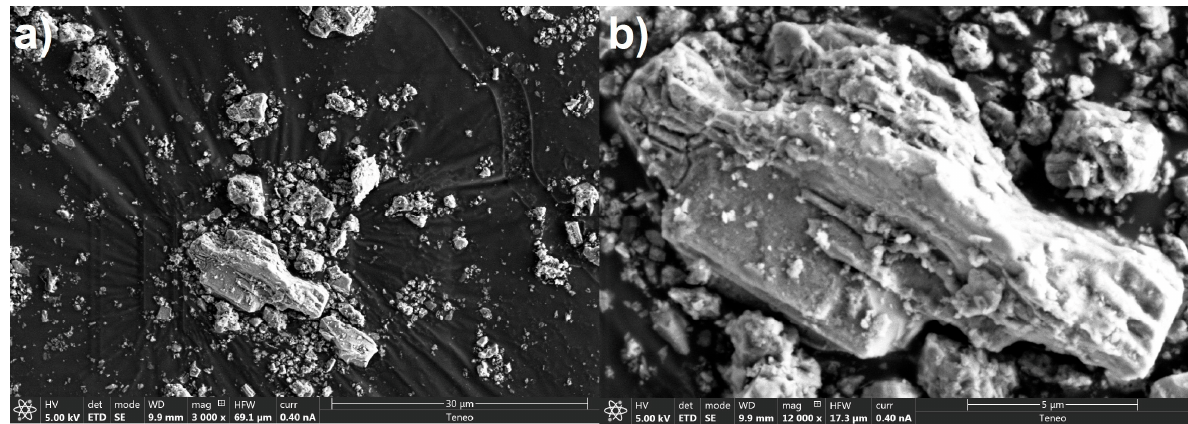
Figure 2. Ladle furnace slag grading curve.